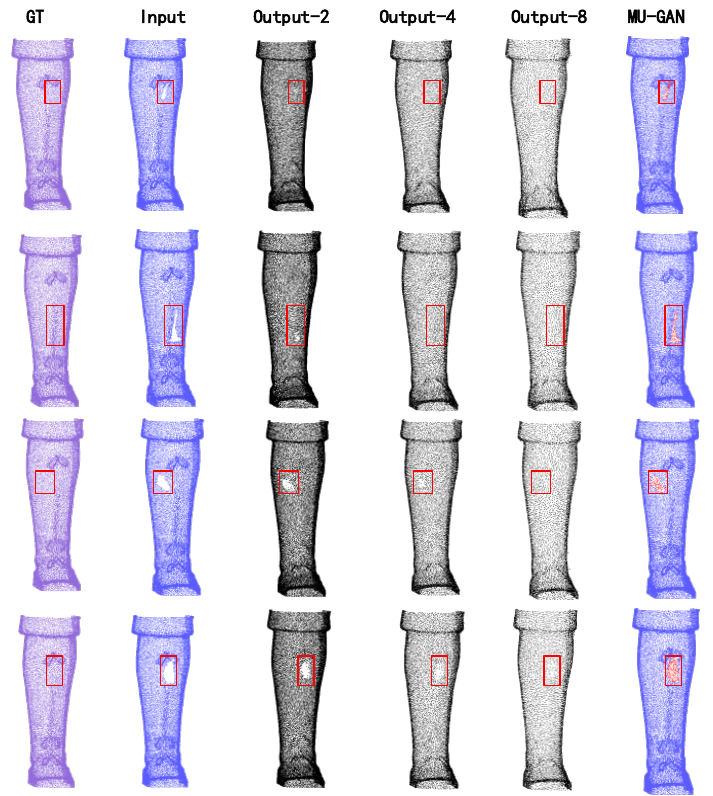
Figure 8. Experimental results of one CHarts model with different hole sizes, and the size increases from top to bottom. The missing ratios of the model are 3%, 5%, 10%, and 15%, respectively.